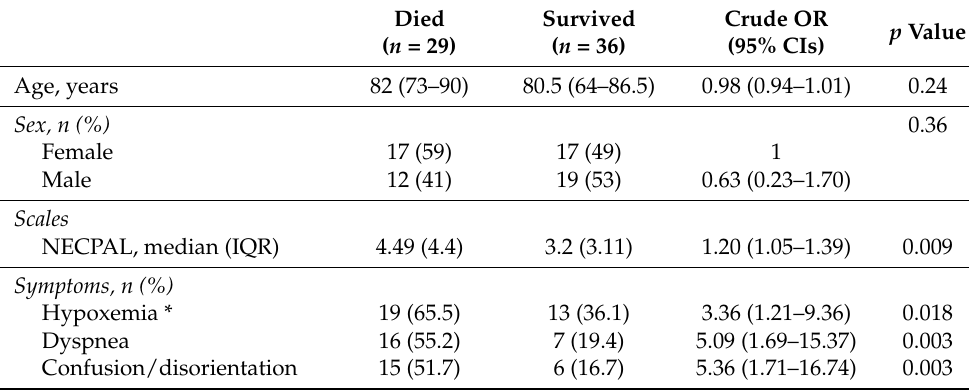
Table 4. Significant clinical characteristics in patients with nosocomial COVID-19 infection according to